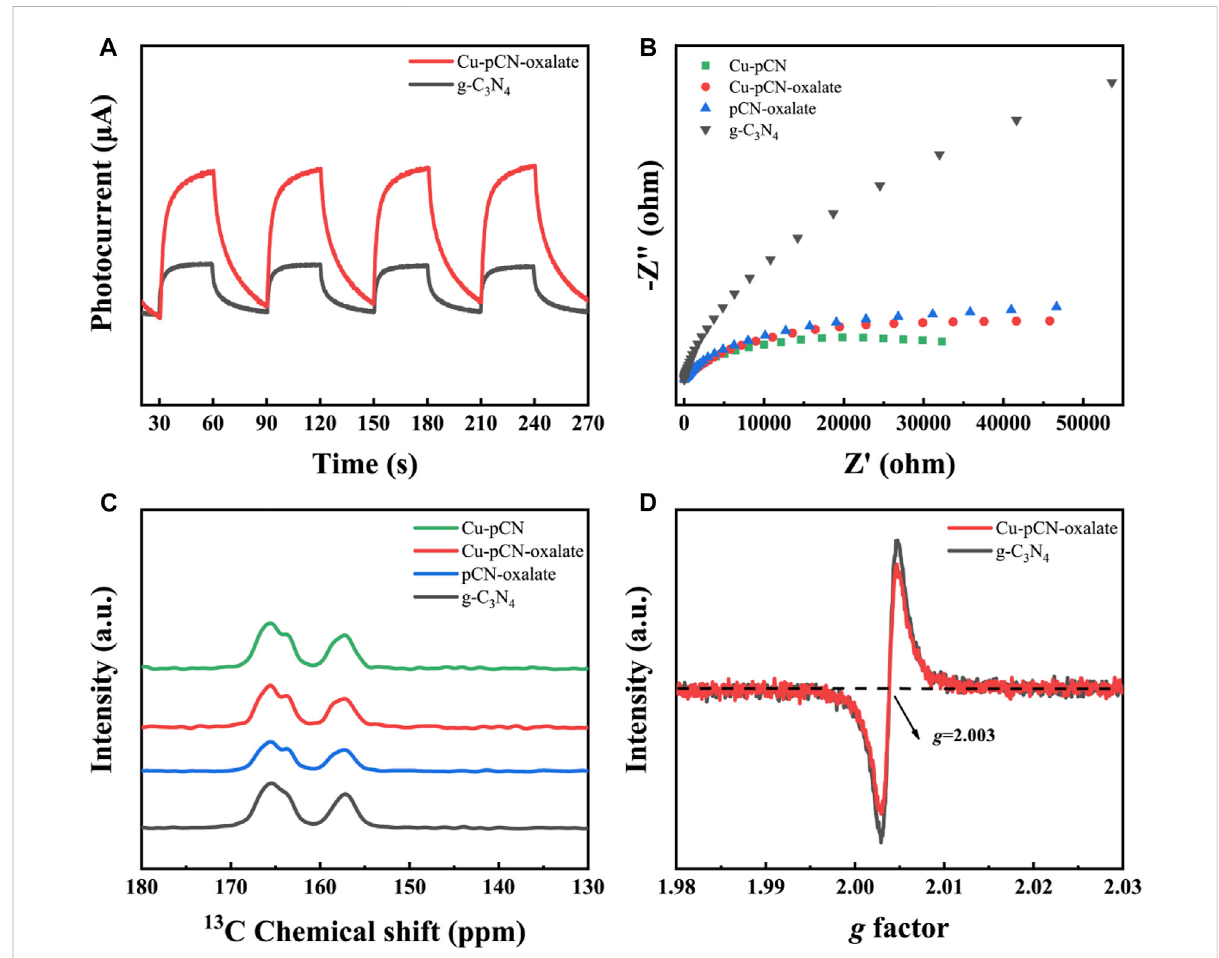
FIGURE 7 (A) Photocurrents and (B) EIS spectra of raw g-C 3 N 4 , Cu-pCN-oxalate, and controls. (C) Solid-state 13 C NMR spectra of Cu-pCN-oxalate samples and (D) solid-state EPR spectra of raw g-C 3 N 4 and